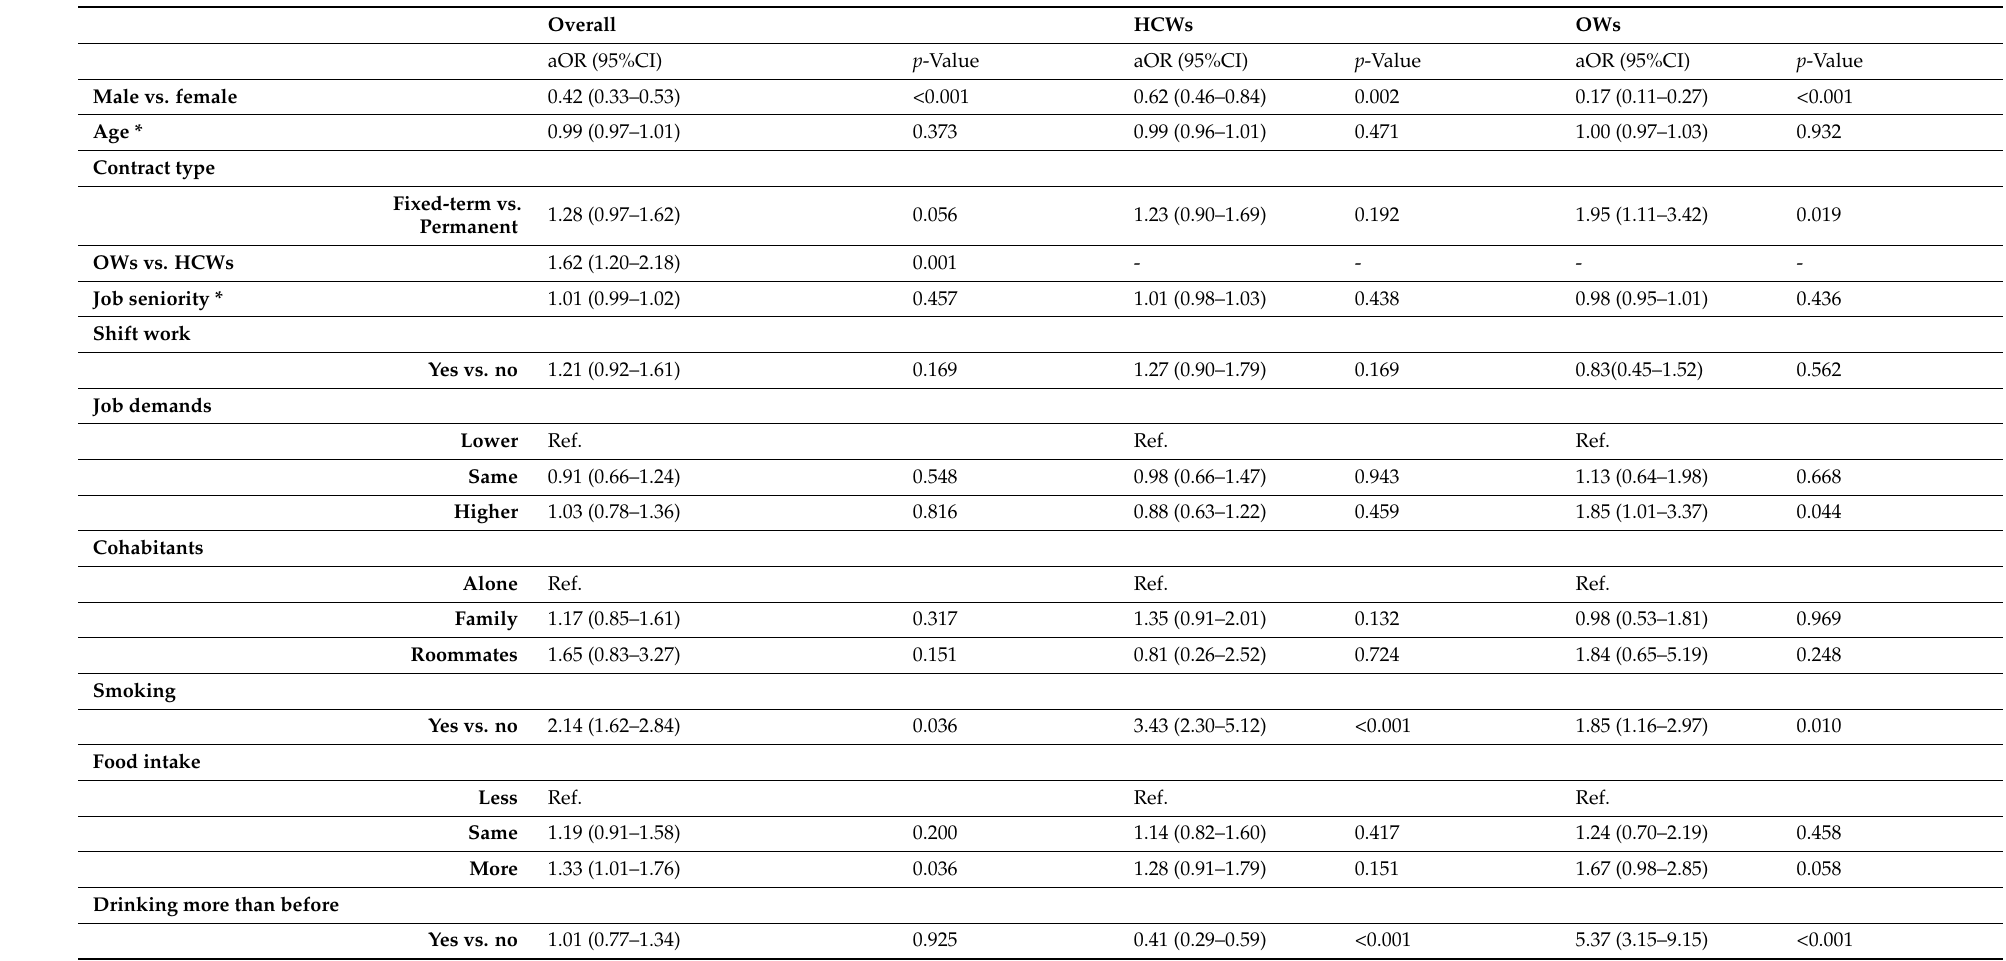
Table 2. Multivariable logistic regression model results, dependent variable (harmful alcohol